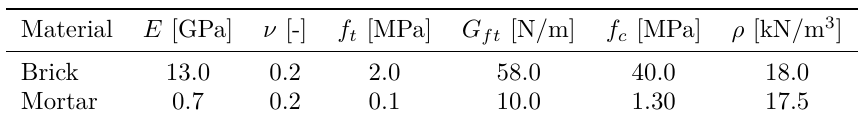
Table 1. Material parameters of brick and mortar.